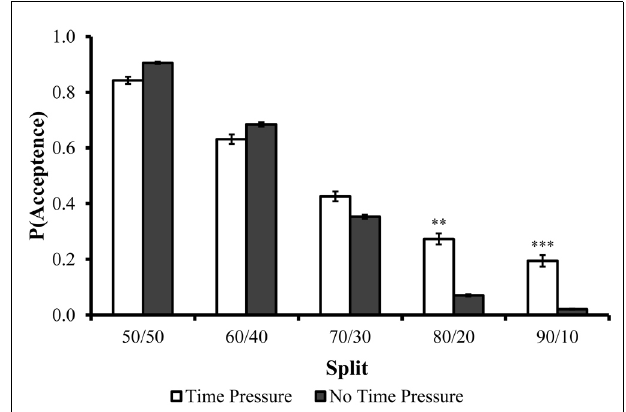
FIGURE 1 | Acceptance rates of each split as a function of the time constraint condition in Experiment 1. Error bars are depicted in black lines. ** p < 0.02, *** p <